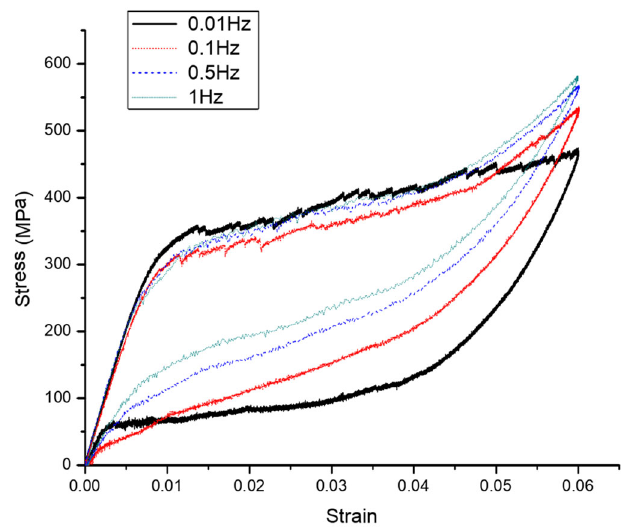
Figure 1. Hysteresis curves of shape memory alloy.